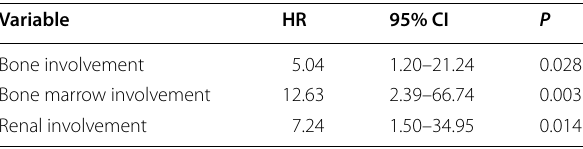
Table 5 Multivariate analysis of risk factors for CNS relapse in the R-CHOP set